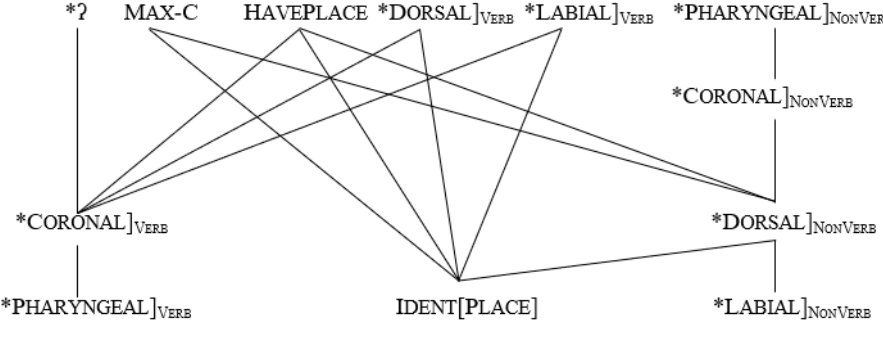
(80) Final ranking for PoA of latent segments in Capanahua